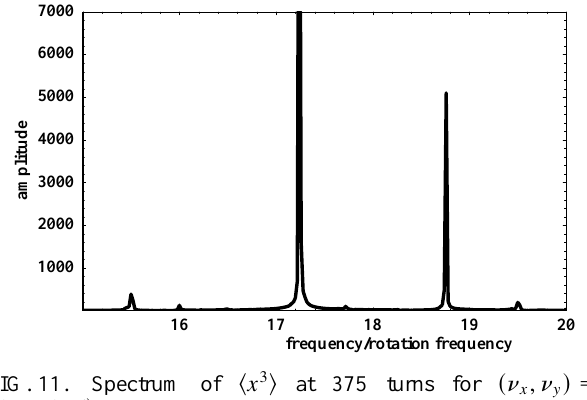
FIG. 11. Spectrum of (cid:5) x 3 (cid:6) at 375 turns for (cid:1) n x , n y (cid:2) (cid:1) (cid:1) 5.82, 5.86 (cid:2) .